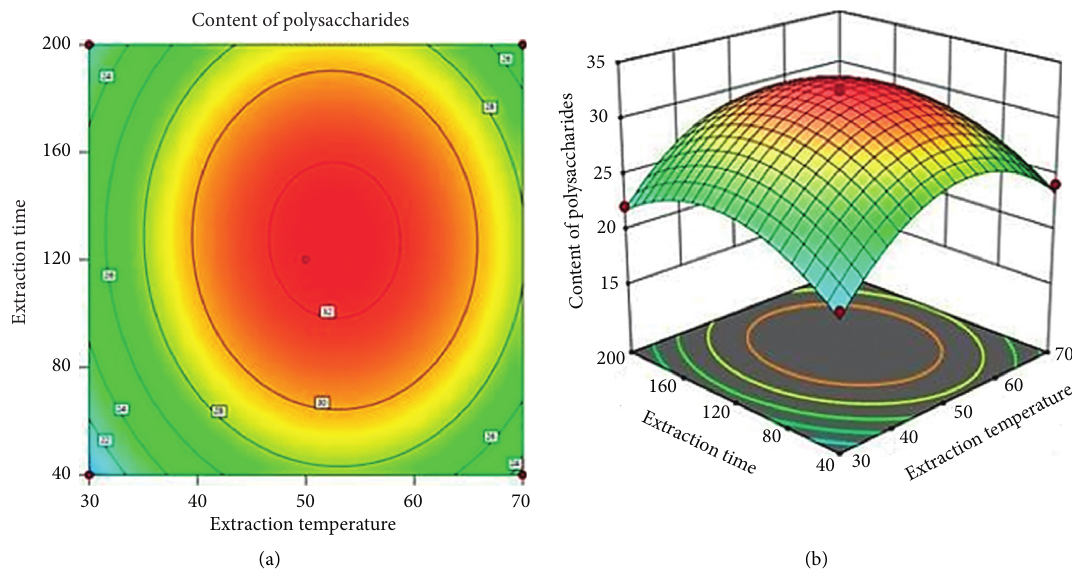
Figure 5: Simultaneous effect of extraction temperature and extraction time on the content of